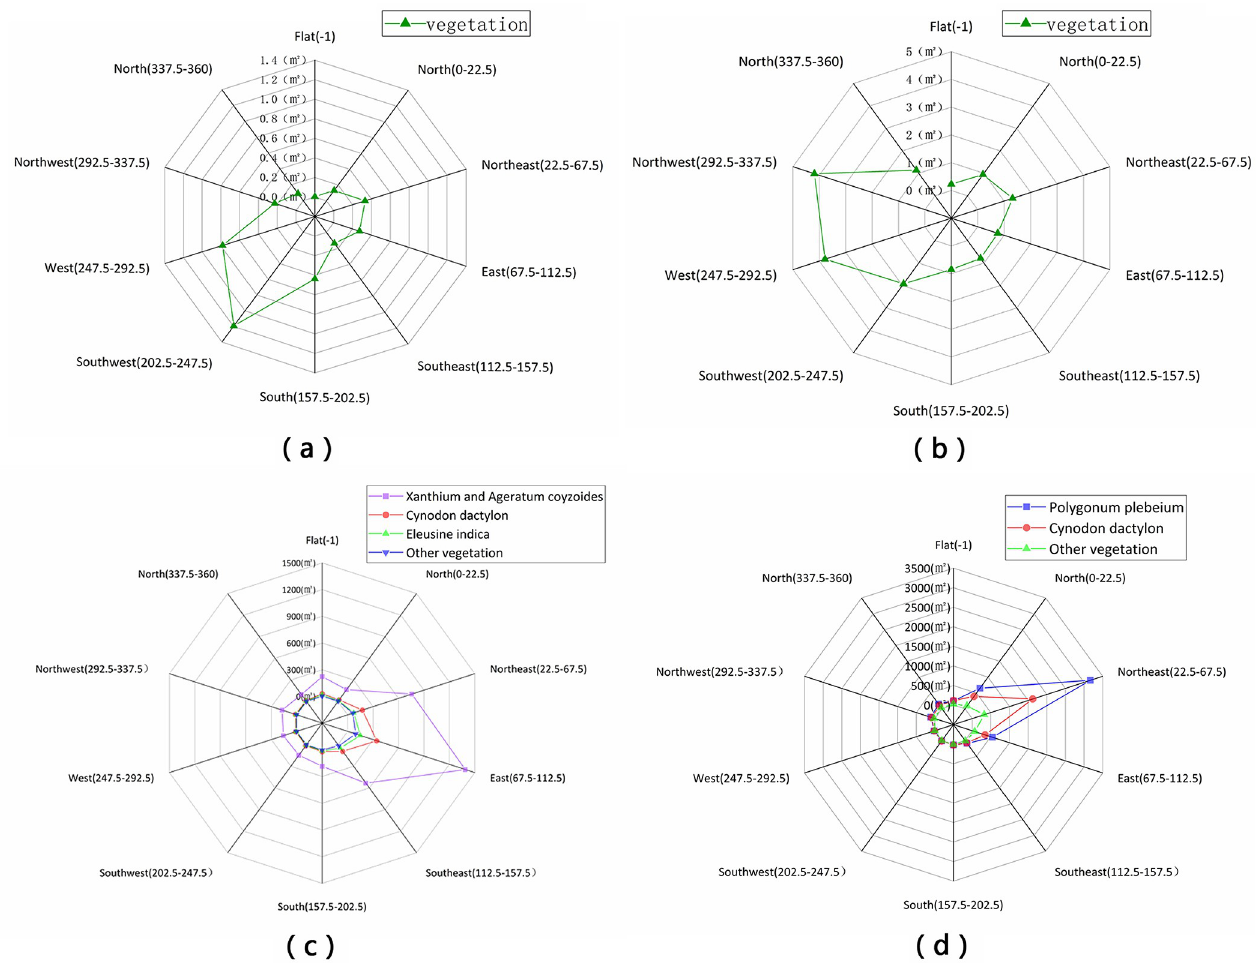
Fig 10. Vegetation distribution area as a function of aspect in the WLFZ of (a) Huangdeng study area 1, (b) Huangdeng study area 2, the (c) Nuozhadu study area, and the (d) Xiaowan study